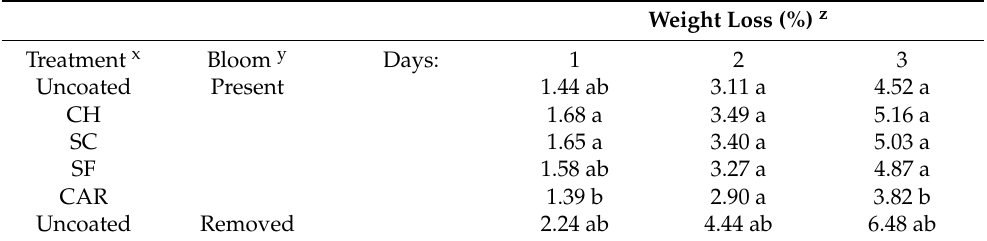
Table 4. Influence of prior epicuticular bloom removal on coating performance during storage at 20 °C.